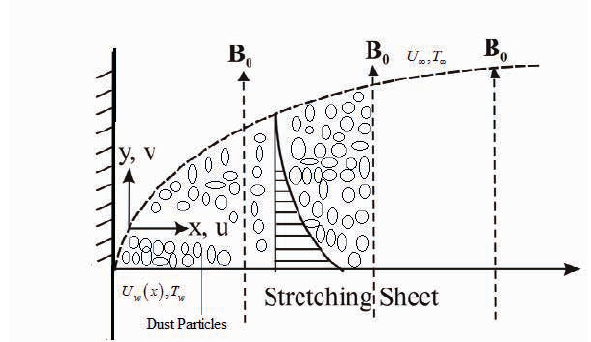
Fig. 1: The physical geometry of flow